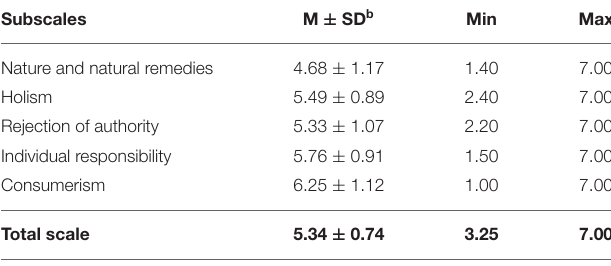
TABLE 4 | Relationship between the owner’s personal cannabinoid (CBD) use and use in dogs and